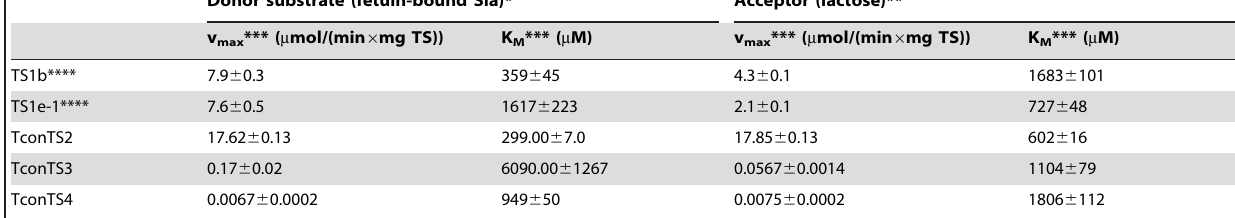
Donor substrate (fetuin-bound Sia)* Acceptor